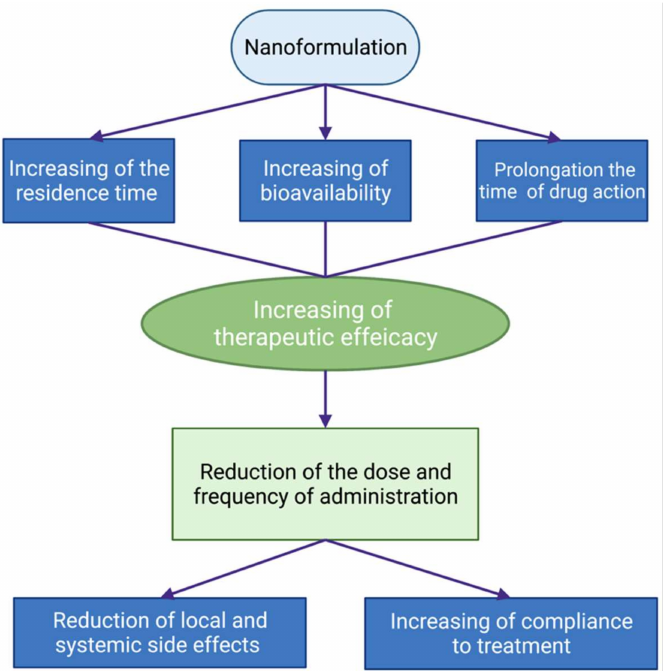
Figure 4. Schematic presentation of the advantages of the use of nanoformulations of ophthalmic drugs. Created with